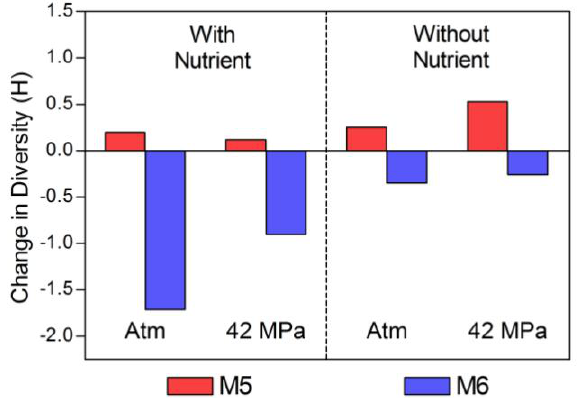
Figure 5. Change in total prokaryotic community diversity (Shannon index, H) relative to time zero. Atm: Atmospheric pressure; M5: High chlorophyll (red); M6: Low chlorophyll